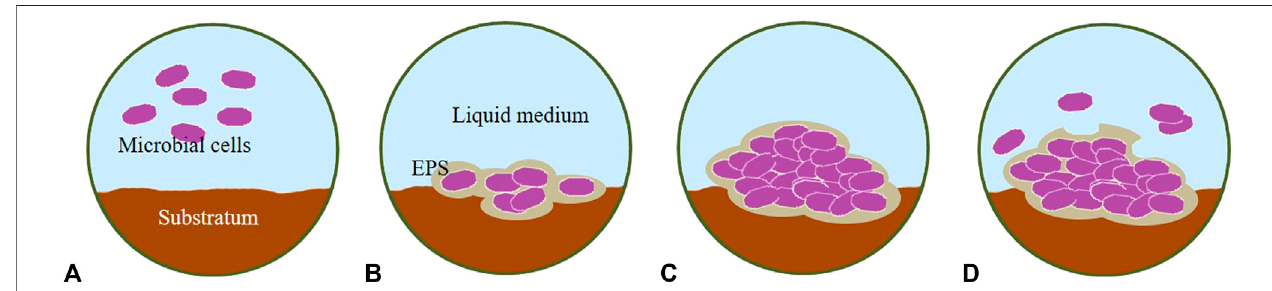
FIGURE 3 | Stages of bio fi lm development. (A) initial attachment, (B) irreversible attachment, (C) development/growth and (D) maturation/detachment. EPS, Extracellular Polymeric